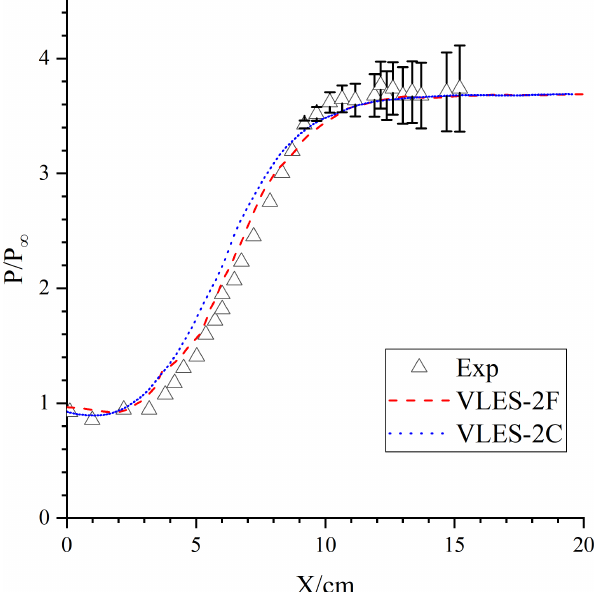
Figure 12. Comparisons of wall pressure distributions on different grids using the VLES-2